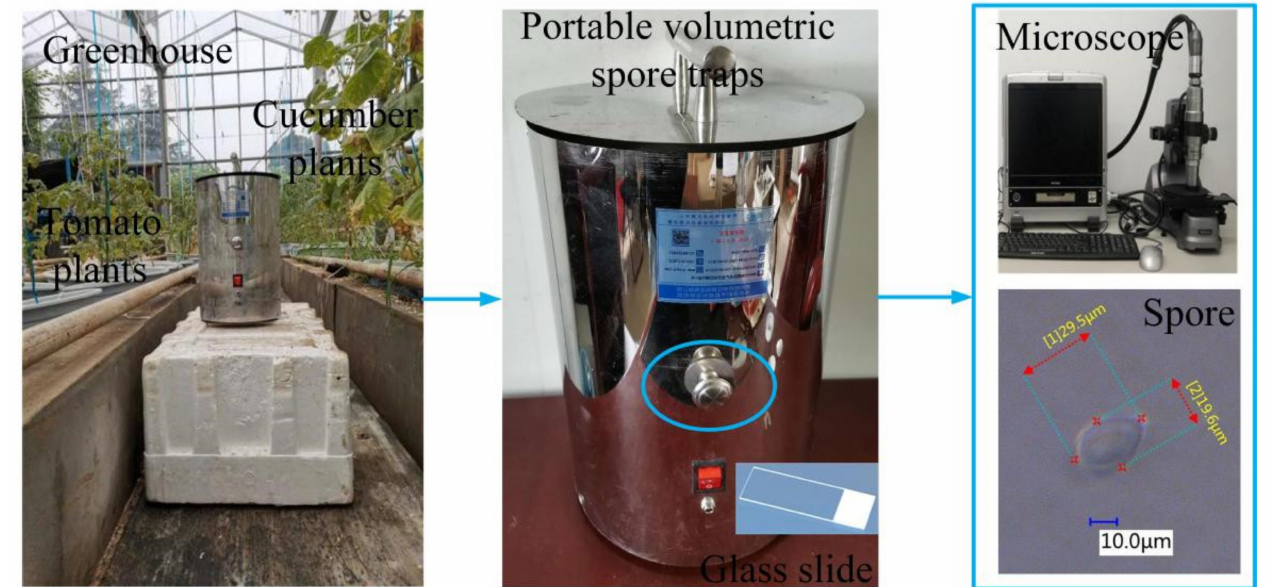
Figure 1. Process of collecting fungal spores and measuring